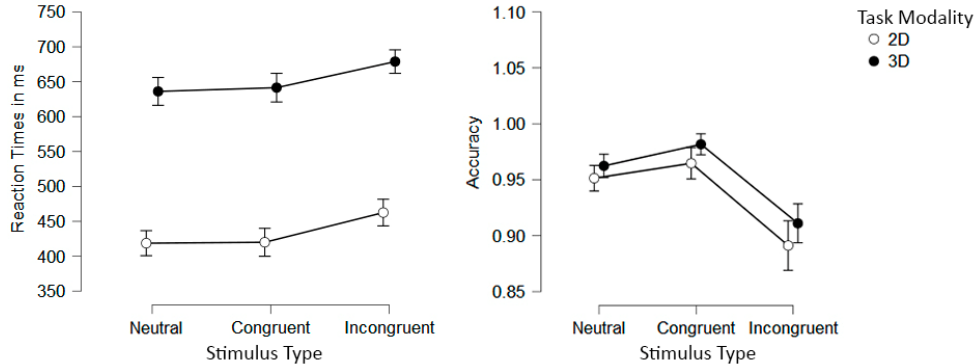
Figure 3. Mean RT ( left ) and accuracy ( right ) per Stimulus Type and Task Modality presentation conditions. Error bars represent 95% confidence intervals.